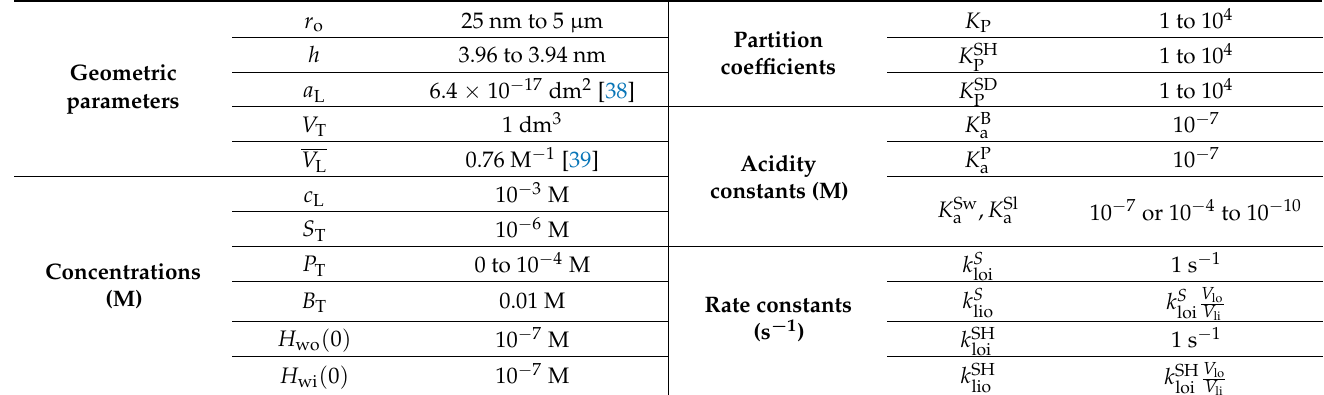
Table 1. Parameters used in the simulations of the Model I and